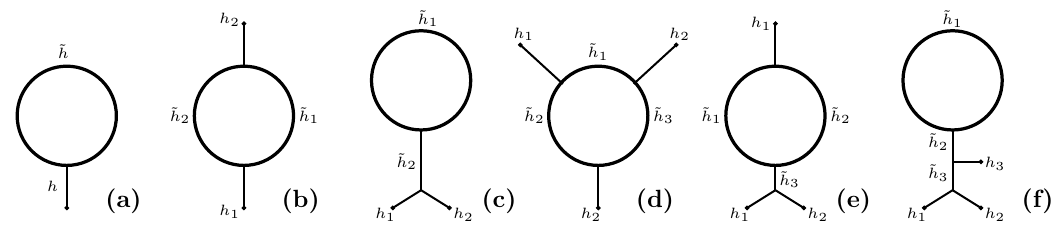
Figure 3 . 1-point block (a) . 2-point torus block in the necklace channel (b) , in the OPE channel (c) . 3-point torus blocks in the necklace channel (d) , in the mixed channel (e) , in the OPE channel (f)